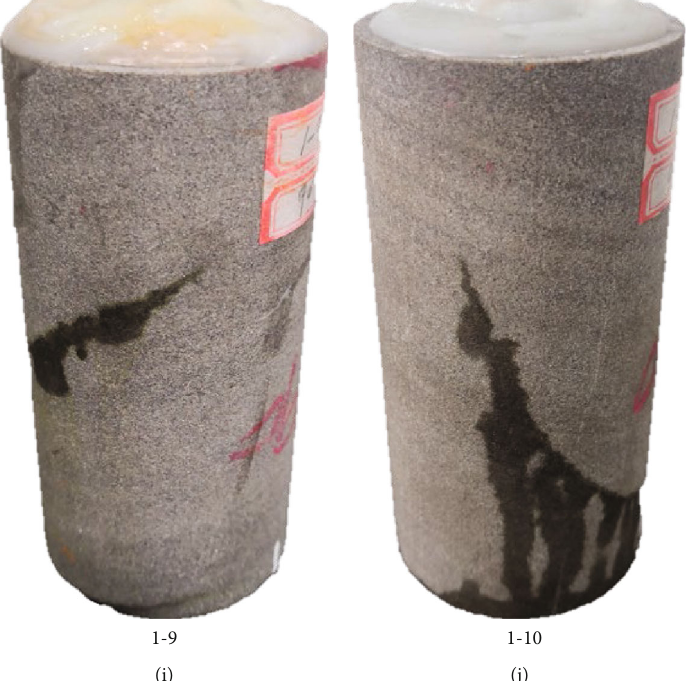
Figure 7: Failure modes of sandstone samples after hydraulic fracturing. (a) 1-1. (b) 1-2. (c) 1-3. (d) 1-4. (e) 1-5. (f) 1-6. (g) 1-7. (h) 1-8. (i) 1-9. (j)